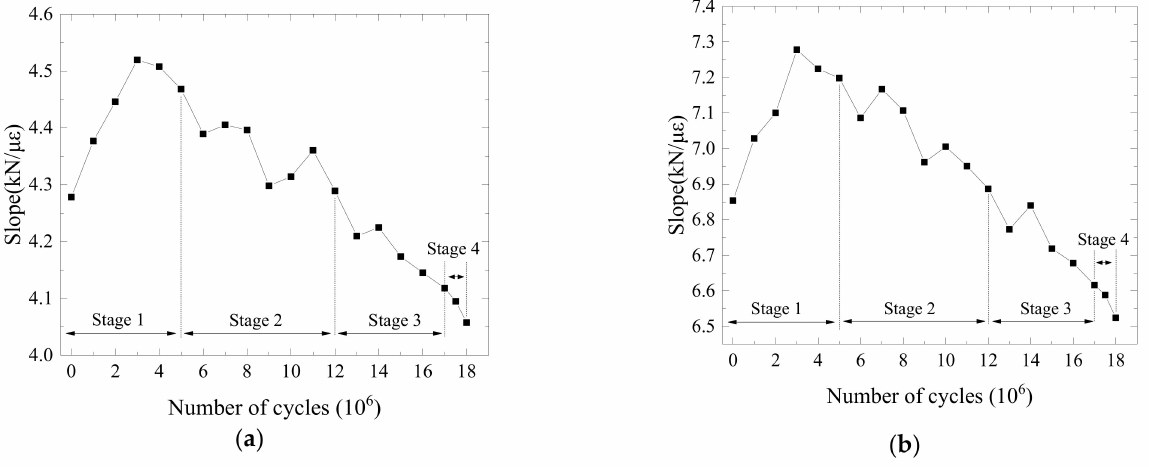
Figure 7. Slope change curve ( a ) L/2 section; ( b ) L/4